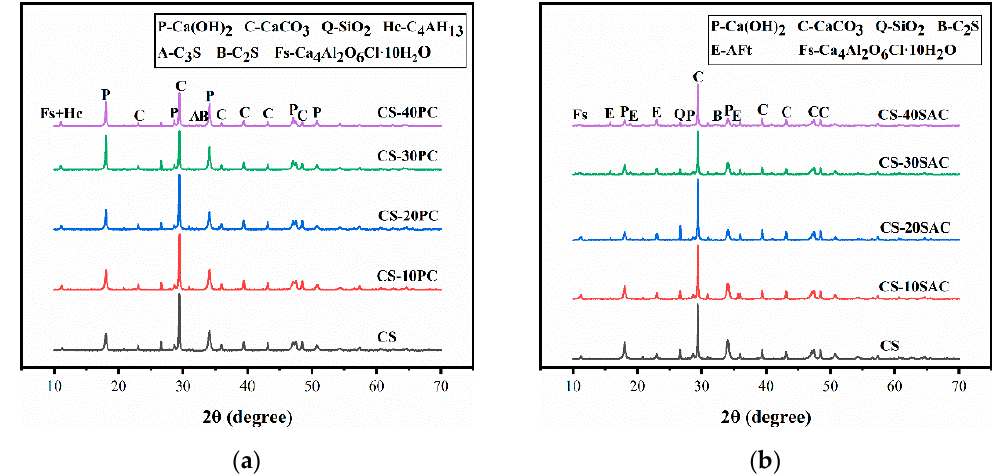
Figure 9. XRD patterns of blended pastes at 28 days: ( a ) CS-PC blended pastes; ( b ) CS-SAC blended pastes.